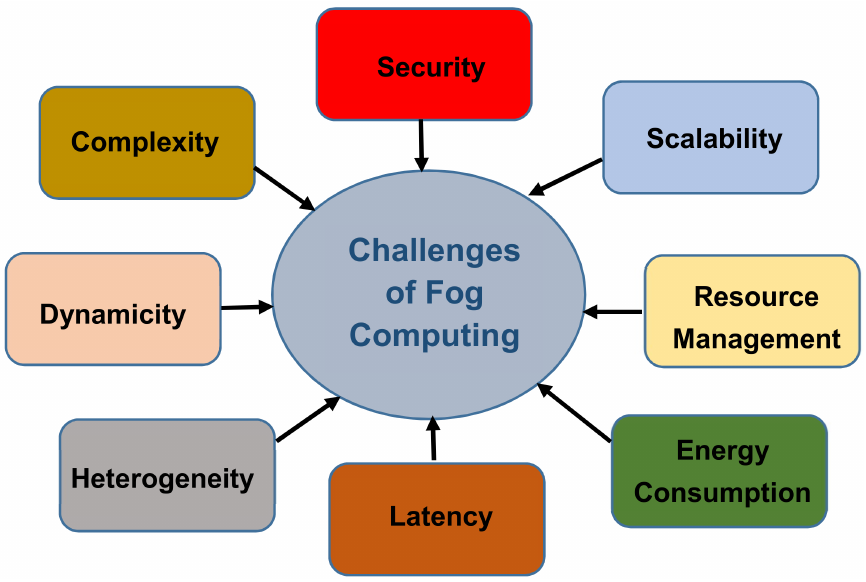
Figure 4. Challenges of fog